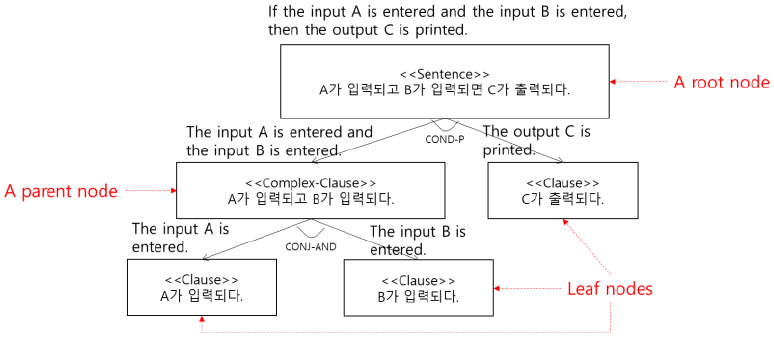
Figure 8. C3Tree model for representing sample sentences.